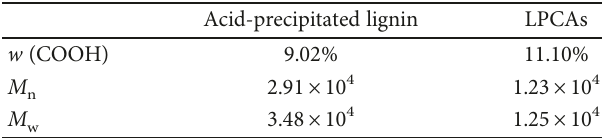
Table 1: The titration analysis and GPC characterization results of acid-precipitated lignin and